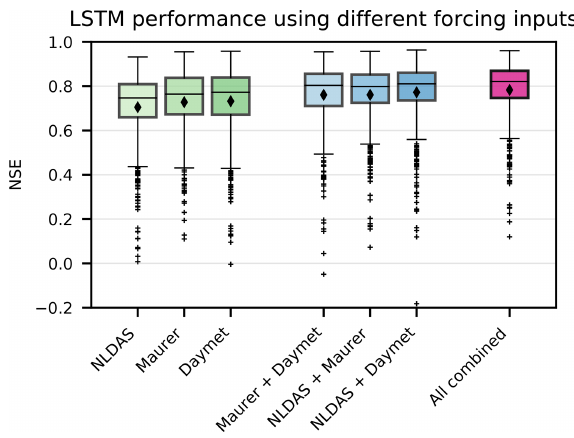
Figure 3. Test period comparison between single-forcing and multiple-forcing LSTM ensembles ( n = 10) over 531 CAMELS basins. All differences were statistically significant ( α = 0 . 001), with the exception of Daymet vs. Maurer ( p ≈ 0 . 08) and NLDAS and Maurer vs. Maurer and Daymet ( p ≈ 0 .